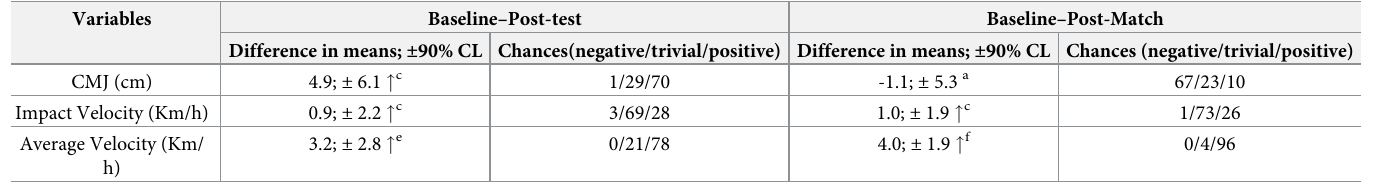
Table 2. Descriptive statistics for the traditional vs differential learning training sessions. Variables Baseline–Post-test